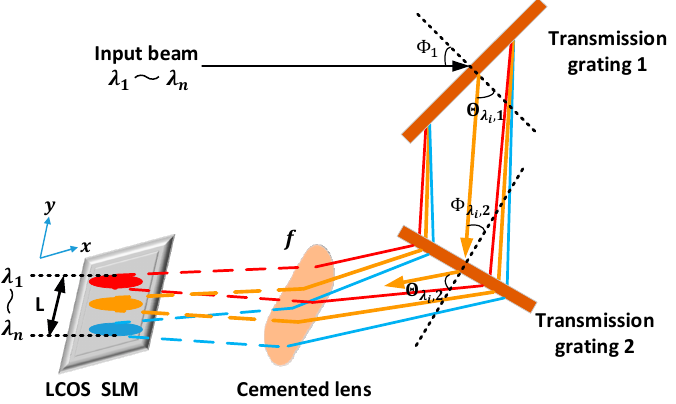
Figure 1. Operation principle of the liquid-on-crystal (LCoS) based programmable PSP using dual-grating.